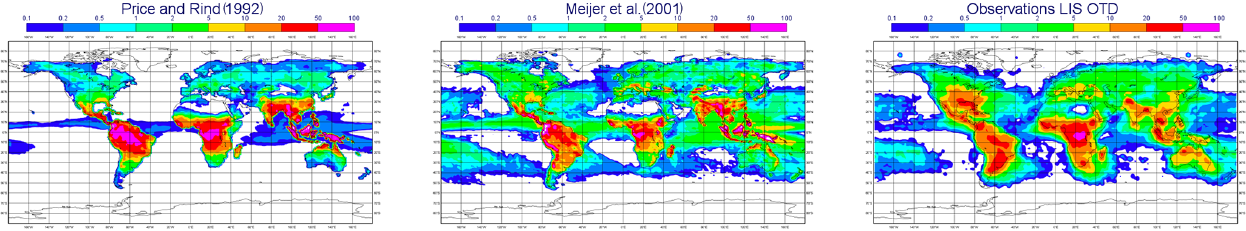
Figure 1. Flash density in flashes ( km − 2 yr − 1 ) from the IFS input data using the parameterisation by Price and Rind (1992) (left), Meijer et al. (2001) (middle) and observations from the LIS OTD database (right). All fields were scaled to an annual flash density of 46fls − 1